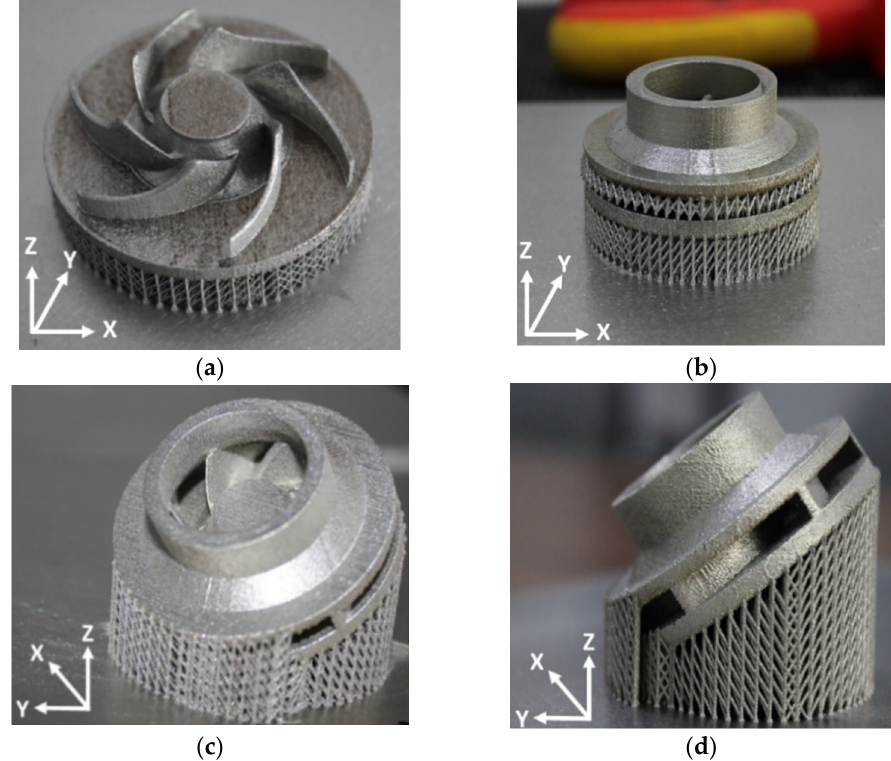
Figure 5. Open impeller and closed impellers built with different orientations on the building plate: ( a ) open impeller—built at orientation of Z axis (building direction); ( b ) closed impeller—built at orientation of Z axis (building direction); ( c ) closed impeller—built at orientation B + 32° (angled 32°); ( d ) Closed impeller—built at orientation B + 45° (angled 45°). Table 4. Average roughness values of as-printed impellers.